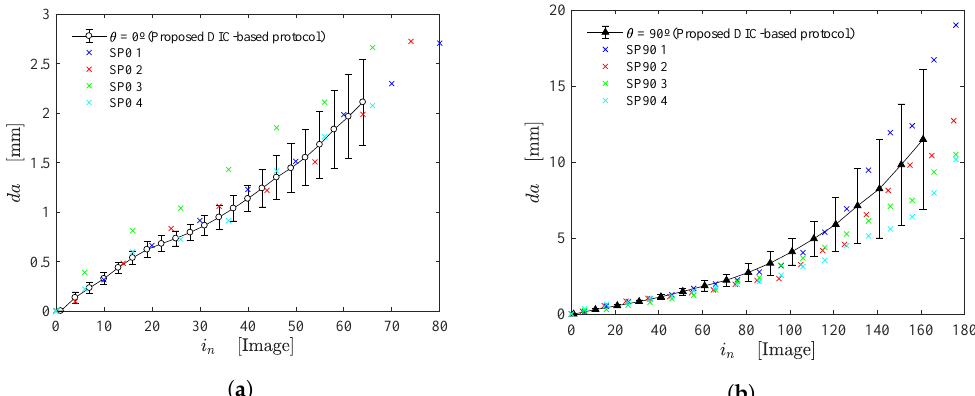
Figure 9. Crack growth ( da ) as function of the number of captured images for fiber orientations of 0 ◦ ( a ) and 90 ◦ ( b ). The continuous curve depicts the proposed method using DIC while the cross symbols show the results of manual